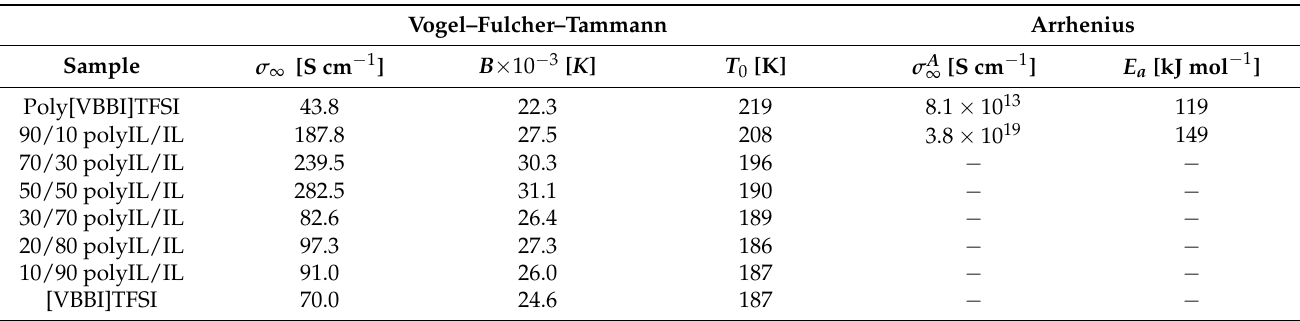
Table 2. Fit parameters of VFT and Arrhenius fits applied to describe the temperature dependence of the ionic conductivity in Figure